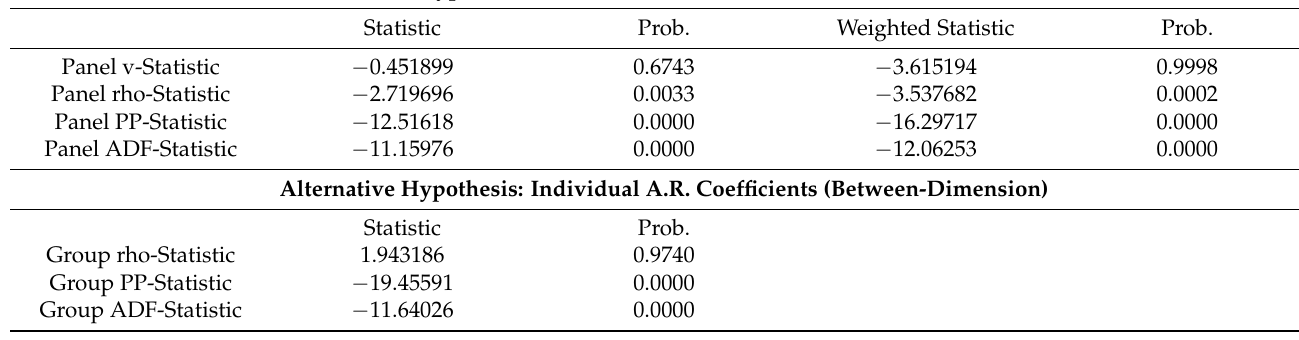
Table 4. Pedroni residual co-integration